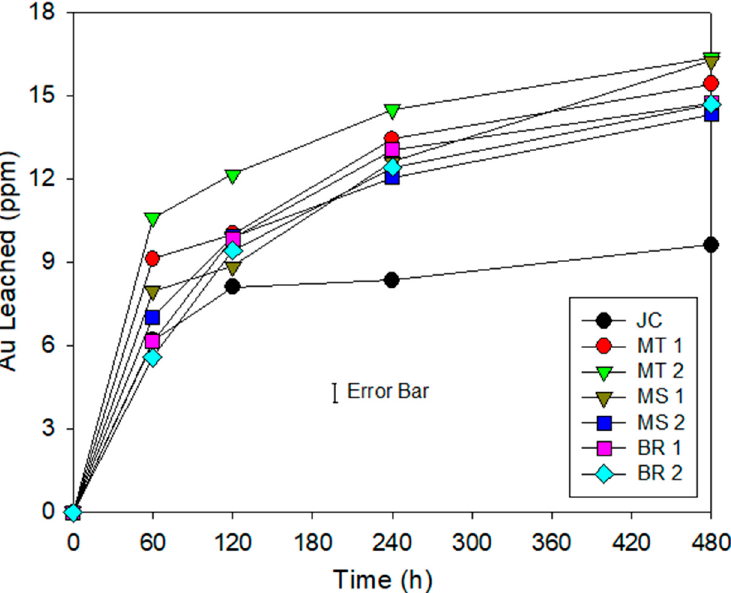
Figure 6. As-received (JC) and mechano-chemically activated JC gold leaching behaviour as a function of time. The mechano-chemically activated samples include those obtained from 5 min (MT1) and 20 min (MT2) milling time; 600 rpm (MS1) and 800 rpm (MS2) milling speed; and ball to pulp ratio of 5:1 (BR1) and 10:1 (BR2). For a given experiment, all other parameters are kept follows: milling time—10 min; milling speed—1000 rpm; and ball to pulp ratio—2:1.